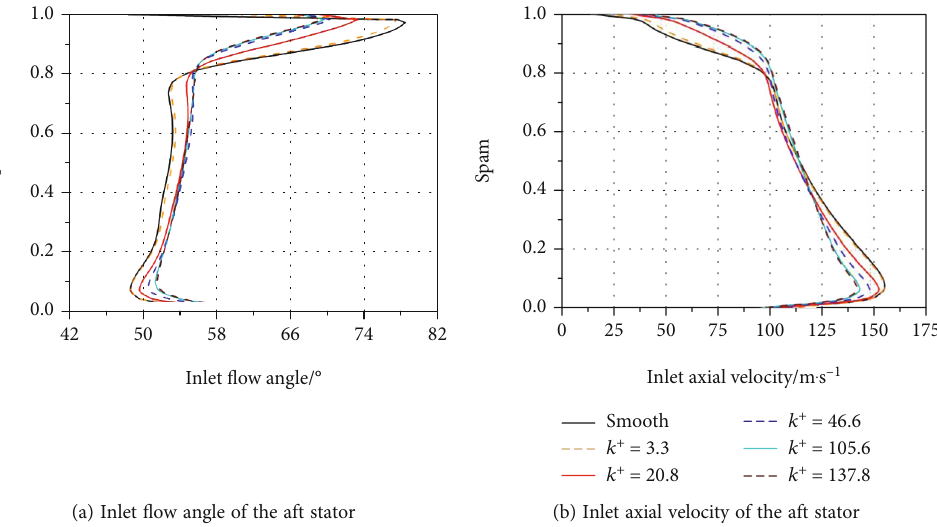
Figure 17: The span distribution of the inlet parameters for the aft stator at di ff erent k + .